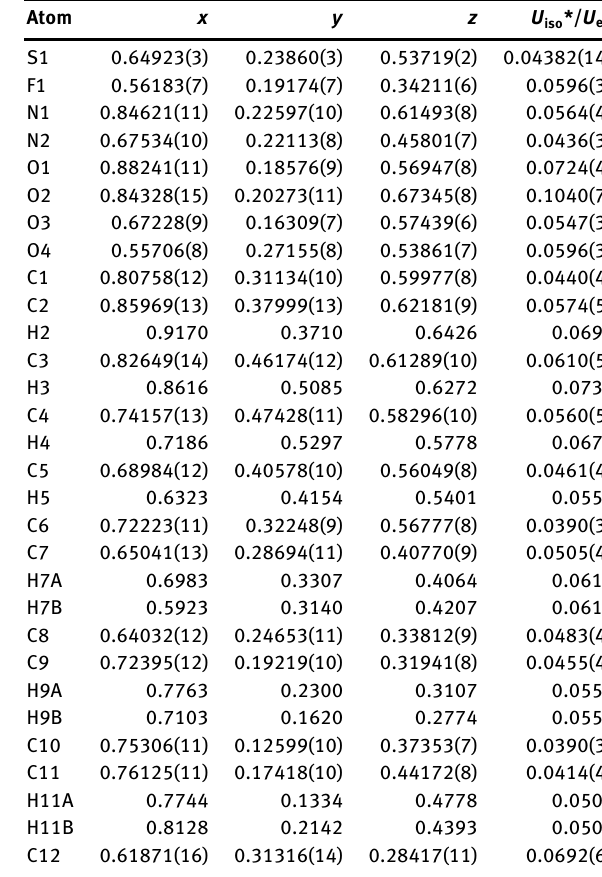
Table 2: Fractional atomic coordinates and isotropic or equivalent isotropic displacement parameters (Å 2